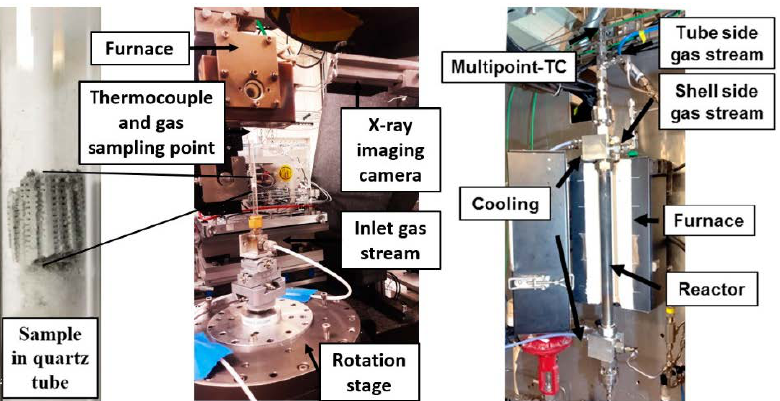
Figure 2. Photo ( left ) of in-situ experimental set up at the ID15A beamline for XRD-CT studies of 3D printed Mn–Na–W–O/SiO 2 catalyst; the set-up comprises a box furnace placed around the reactor cell (see insert left with sample in quartz tube) connected with the required tubing. Photo ( right ) of miniplant experimental setup at Technical University Berlin (TUB). The unit comprises a reactor within a split tube furnace with gas supply from above and an 18-point thermocouple inside the reactor and catalytic